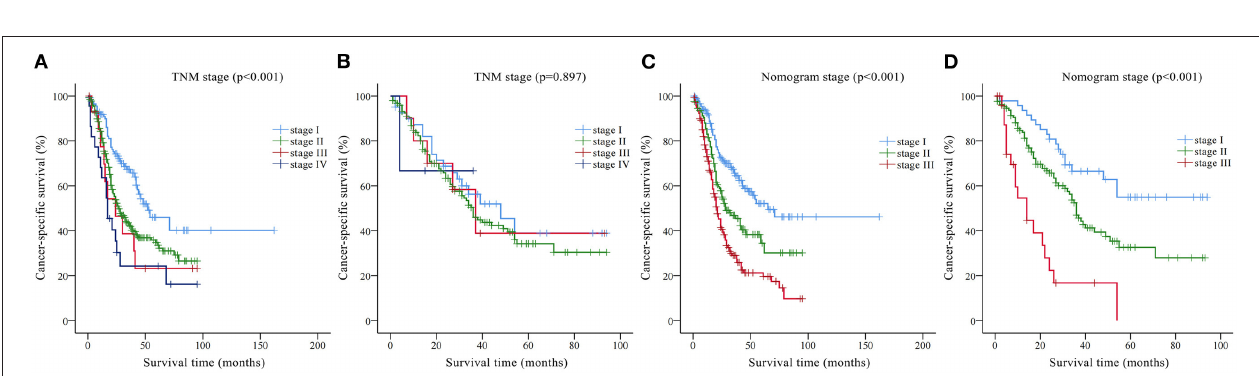
FIGURE 5 | Kaplan-Meier CSS curves categorized by different staging systems: (A) American Joint Committee on Cancer (AJCC) TNM staging system in the training set; (B) AJCC TNM staging system in the validation set; (C) nomogram staging system in the training set; (D) nomogram staging system in the validation set.